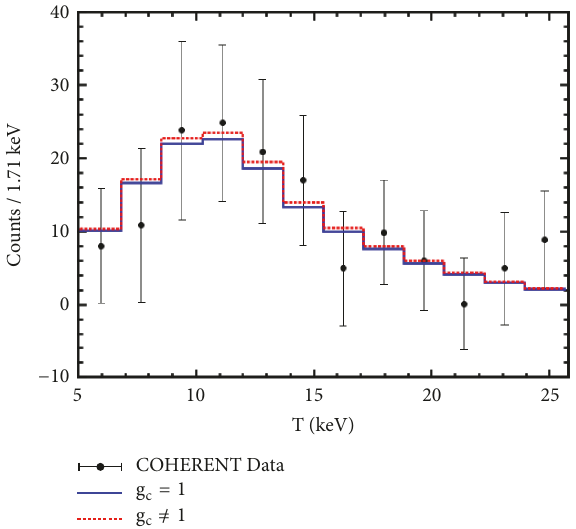
Figure 1: Expected number of events for the CsI COHERENT case. The solid (blue) line corresponds to the usual approach to the cross- section as given in (4) while the dotted (red) line corresponds to the more detailed case discussed in [17]. The points correspond to the experimental data